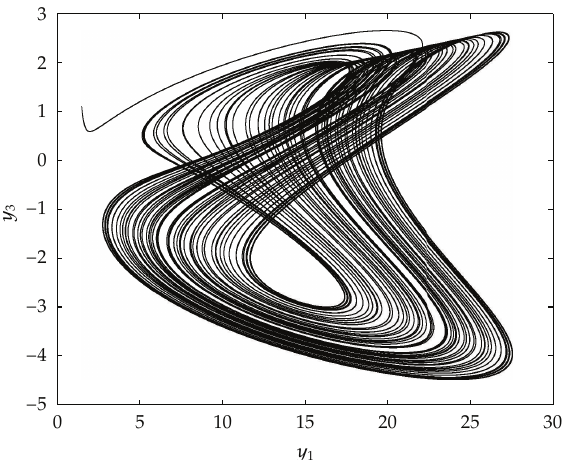
Figure 2: Chaotic behavior of the slave chaotic system under the proposed